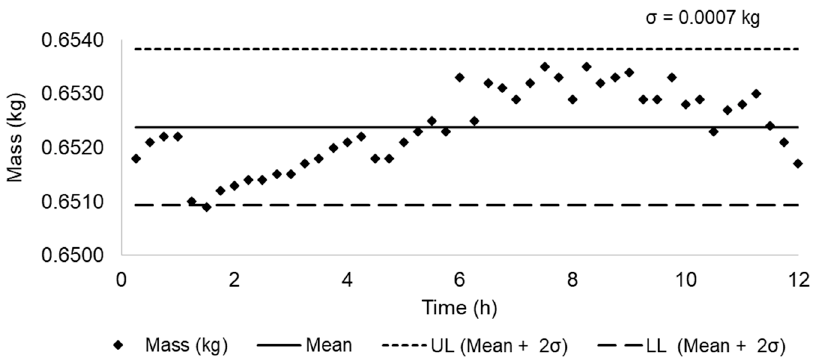
Figure 2. Digital scale calibration along 12 h by applying a constant load.